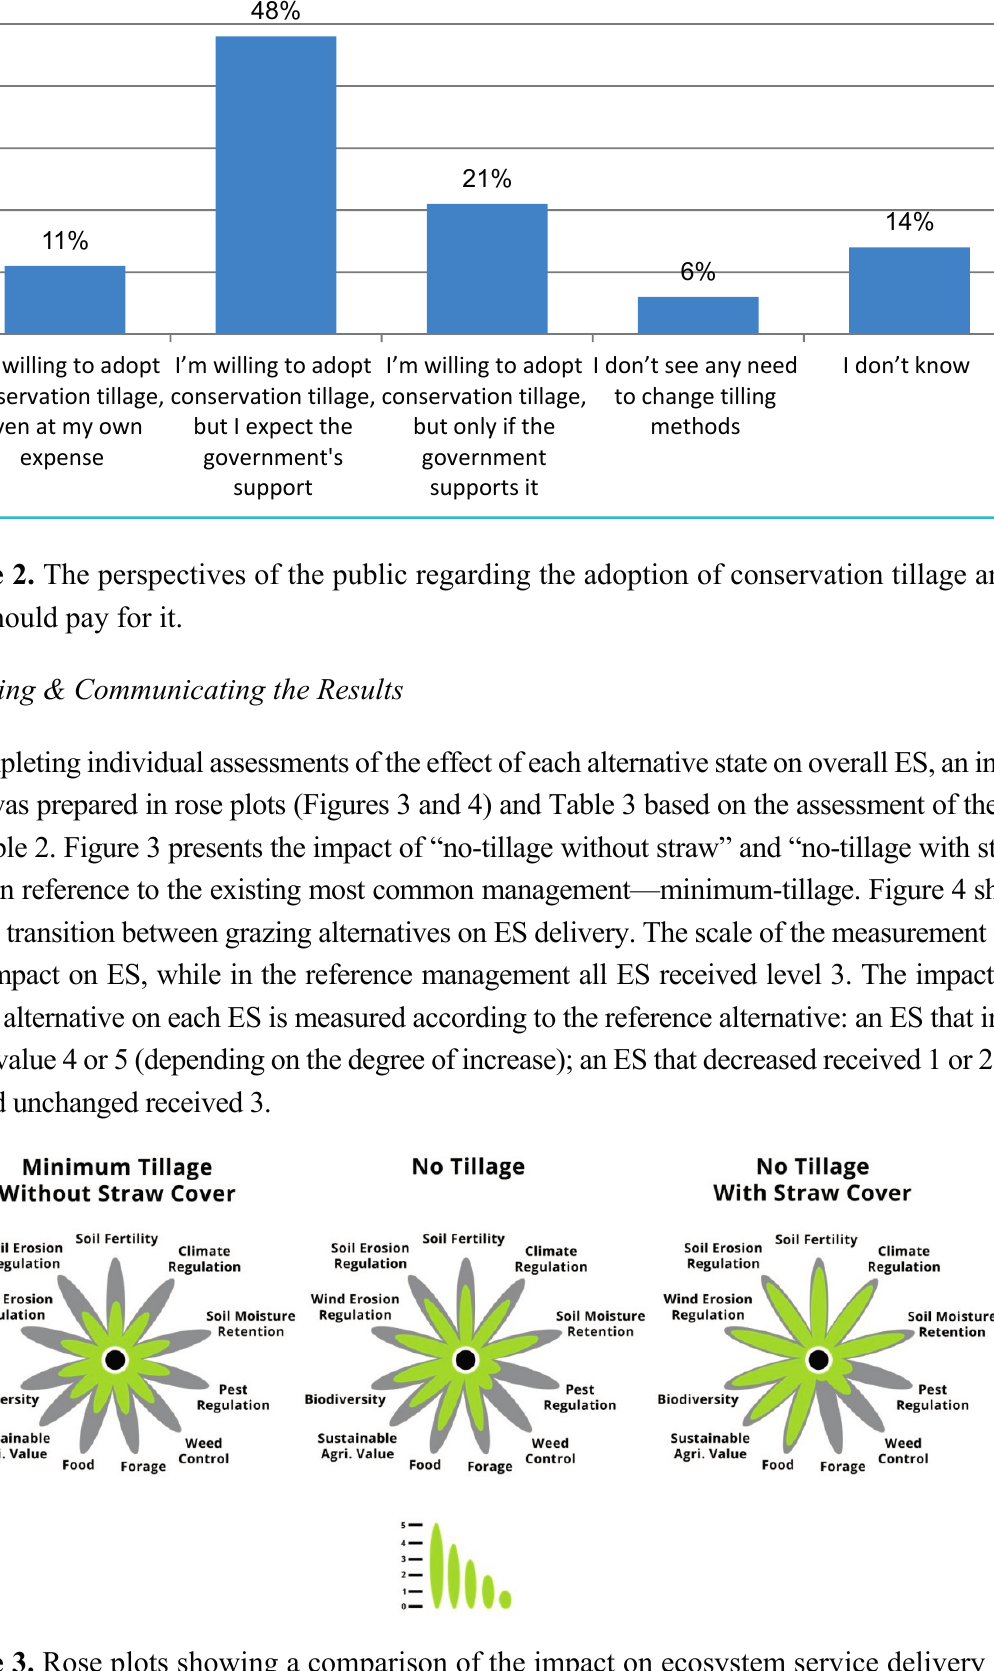
Figure 3. Rose plots showing a comparison of the impact on ecosystem service delivery of no-tillage alternatives in reference to minimum tillage, based on experts’ ES